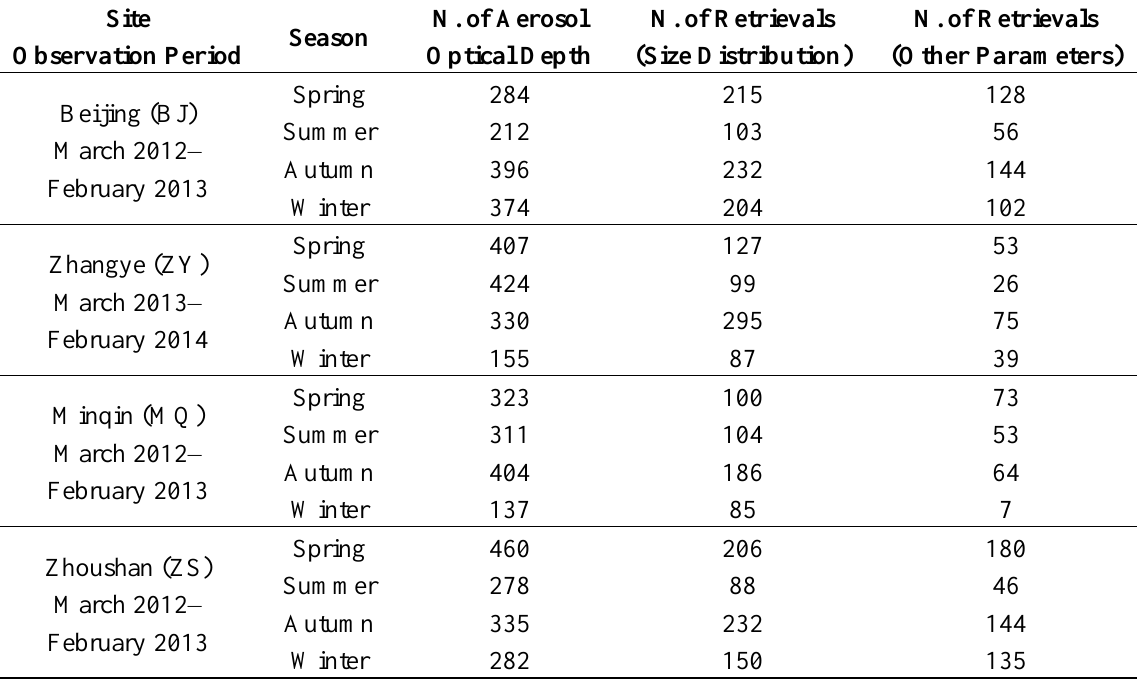
Table 1. Summary of measurements of the four typical sites and seasons *